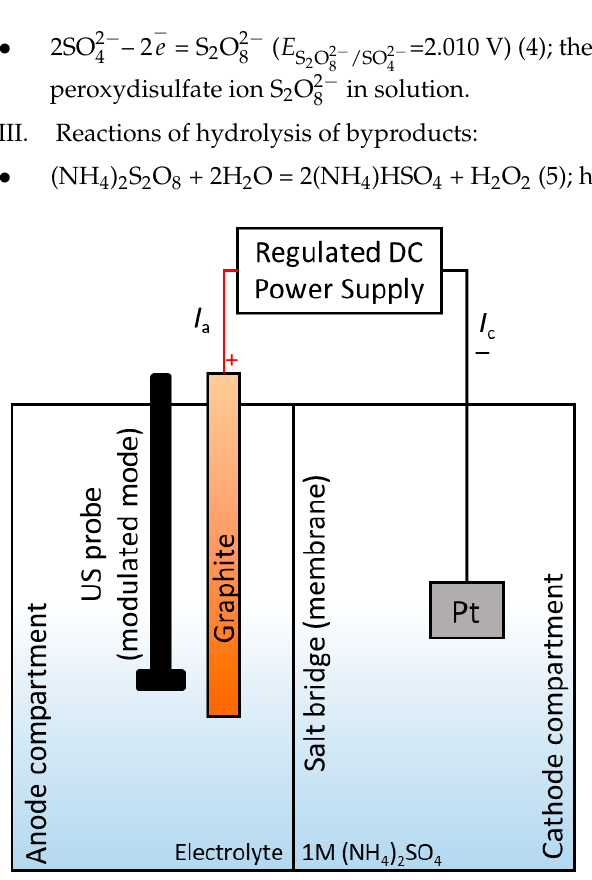
Figure 1. Typical scheme of the experimental setup for obtaining electrochemically generated graphene oxide.